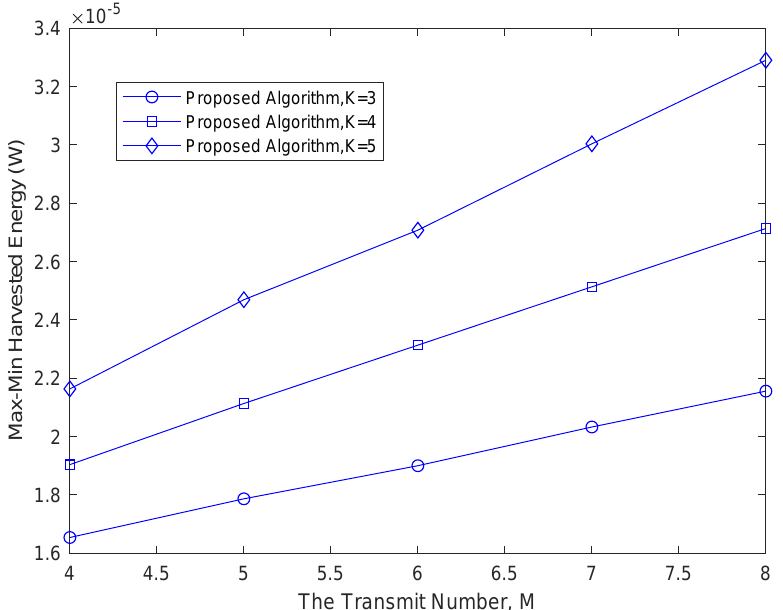
Figure 4. The relationship between the max-min harvested energy and the number of transmit